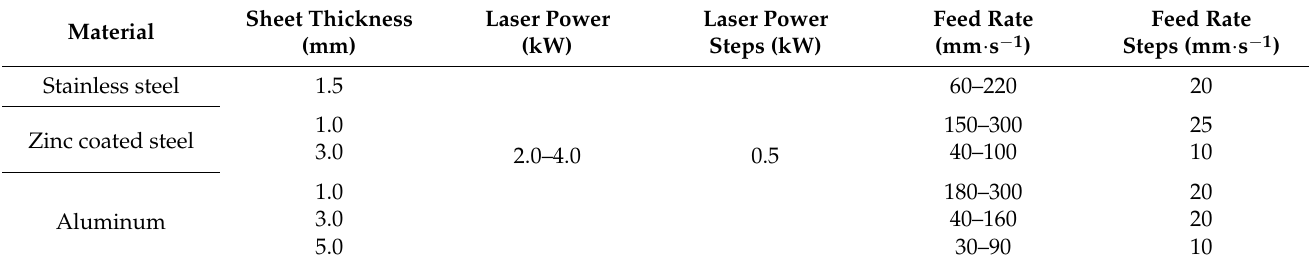
Table 1. Variation of the cut